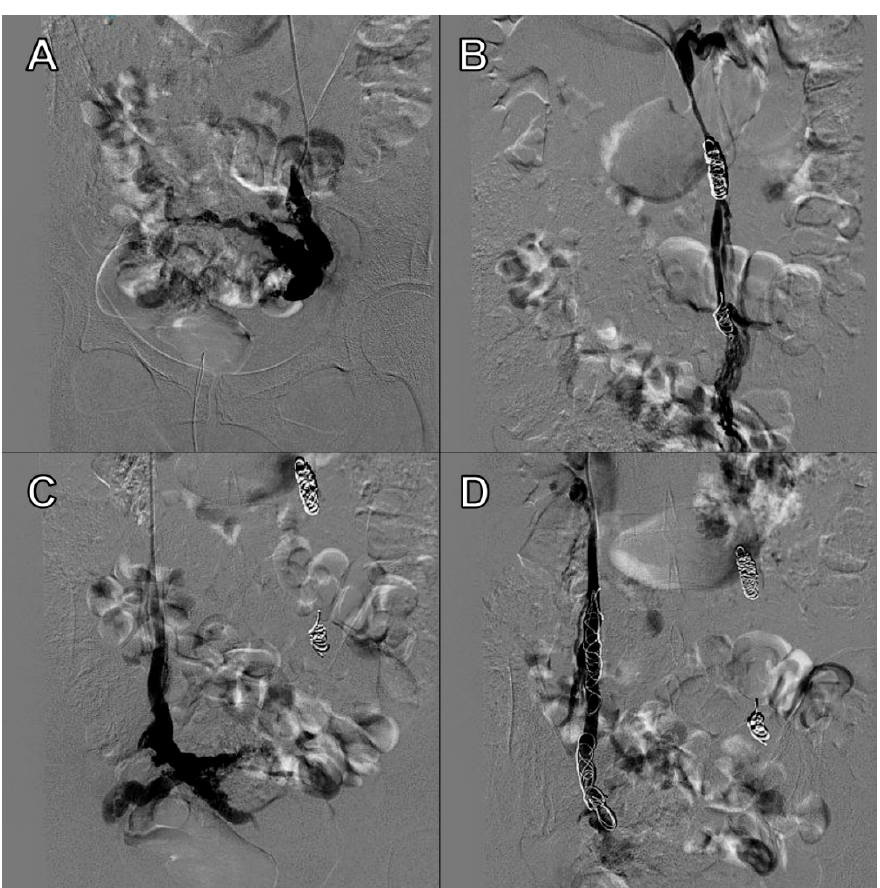
Figure 5. Venography sequence: ( A ) Insufficient left ovarian vein with periuterine varices. ( B ) Com- petent left ovarian vein after embolization. ( C ) Insufficient right ovarian vein with periuterine varices. ( D ) Competent right ovarian vein after embolization.